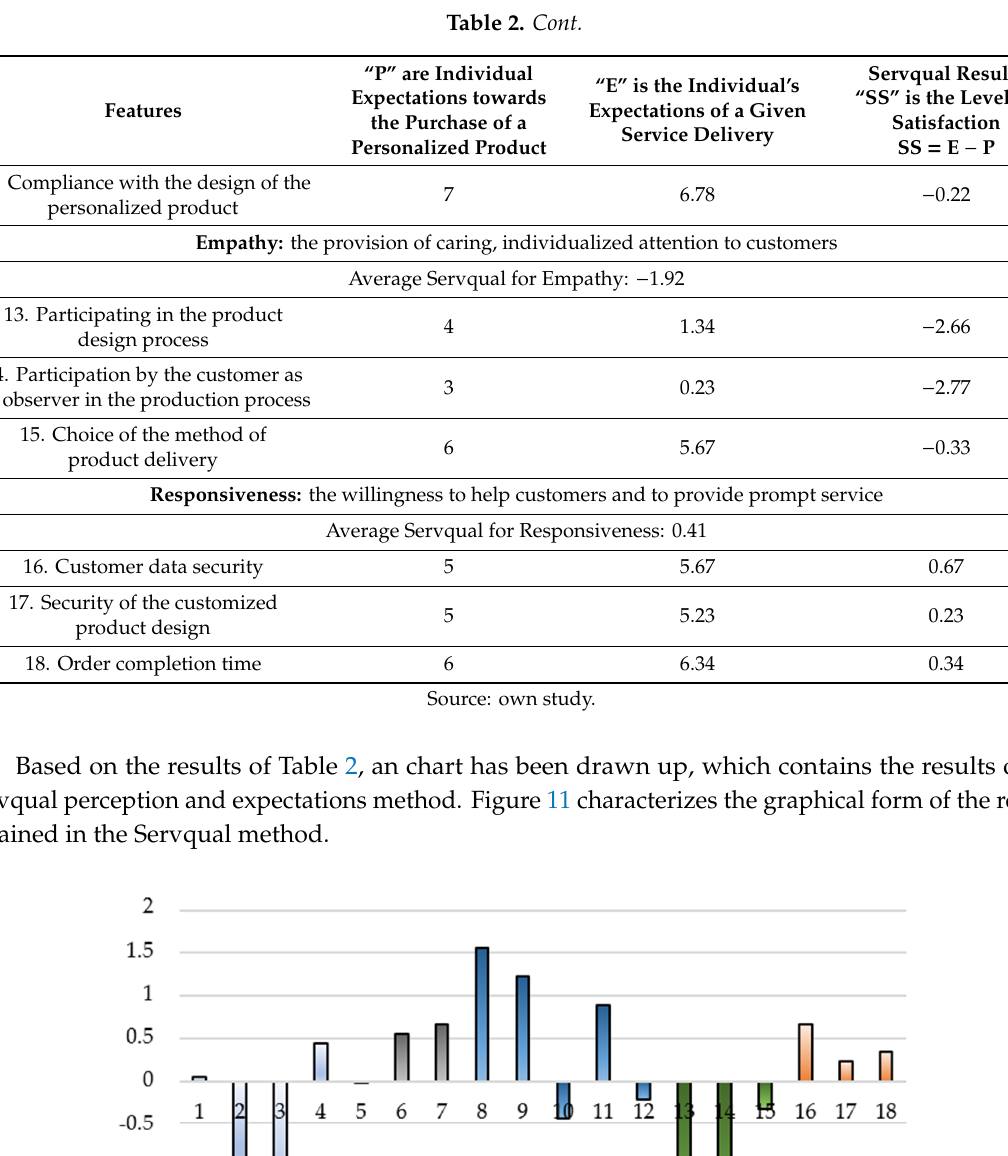
Figure 12. Arithmetic mean score for Servqual analysis dimensions. Source: own study. Positive arithmetic means were obtained for the dimensions: assurance, tangibles, and responsiveness, which means that the satisfaction of the respondents was achieved for these dimensions. The dimensions where the satisfaction of the respondents has not been achieved and needs to be improved are: reliability and empathy. The next step in the Servqual method was to calculate the total arithmetic measure of consumer satisfaction (which is −0.38). The result was negative, but slightly different from zero, which indicates the need to improve the level of service quality when ordering and manufacturing personalized products.